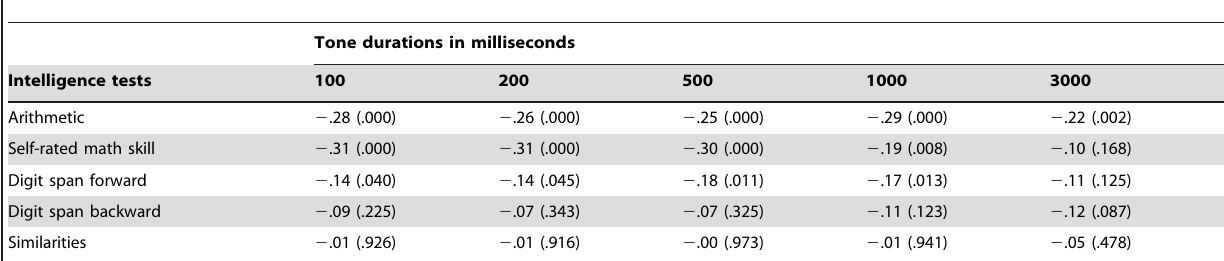
Table 2. Pearson correlations between intelligence and time-estimation error for five different tone durations.